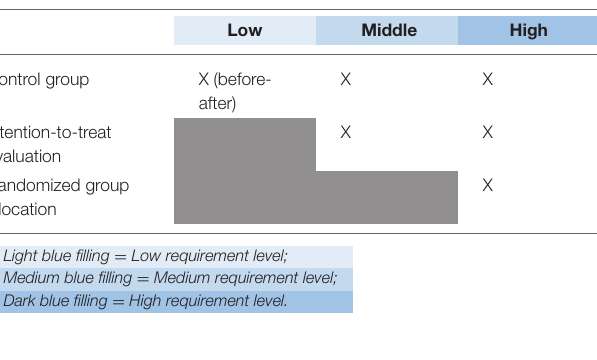
TABLE 3 | Matrix for determining the requirement level and acceptable end points for health effects. Categorization regarding “target